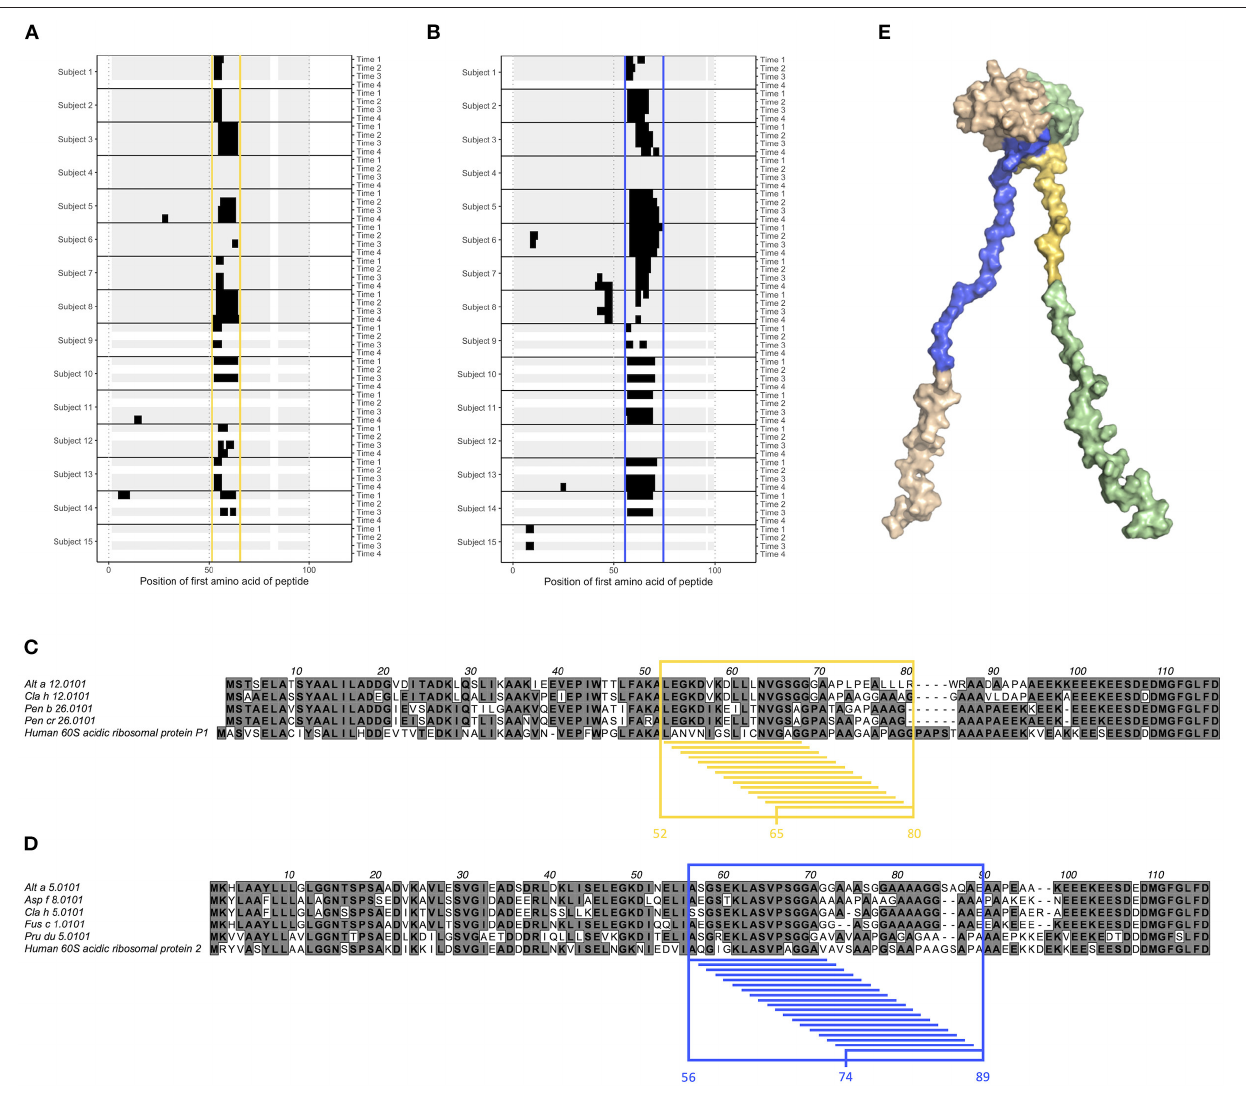
FIGURE 5 | Epitope G (yellow) and H (blue) are found on acidic ribosomal protein 1 allergens and acidic ribosomal protein 2 allergens, respectively. (A,B) Linear epitope recognition pattern of IgG against the acidic ribosomal protein 1 allergen Alt a 12.0101 (A) and the acidic ribosomal protein 2 allergen Alt a 5.0101 (B) with epitope G (yellow) and H (blue) marked. IgG were sampled from allergic individuals at start of AIT treatment (time 1), and 8 weeks (time 2), 1 year (time 3), and 3 years later (time 4). (C,D) Alignment of acidic ribosomal protein 1 allergens together with human acidic ribosomal protein 1 (C) , and of acidic ribosomal protein 2 allergens together with human acidic ribosomal protein 2 (D) . Reactive peptides of epitope G (yellow) and H (blue) have been highlighted, together with all amino acids present in at least one of these peptides. (E) Solution structure (PDB id 4BEH) of human acidic ribosomal protein 1 (green) and 2 (beige) heterodimer with epitope G (yellow) and H (blue)